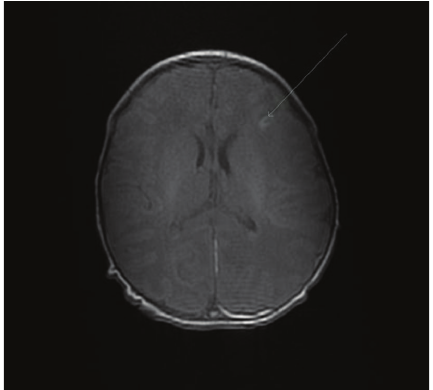
Figure 2: Magnetic resonance imaging demonstrating a 1–1.5 cm focal area of parenchymal abnormality in the left frontal lobe anterolaterally, appearances of which are consistent with